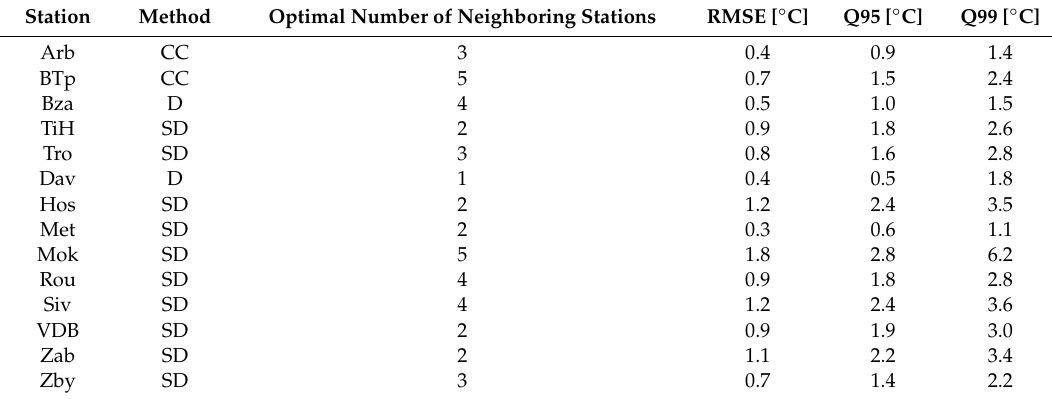
Table 3. Overview of best methods of spatial interpolation for individual stations (CC—correlation coe ffi cient, D—geographical distance, SD—standard